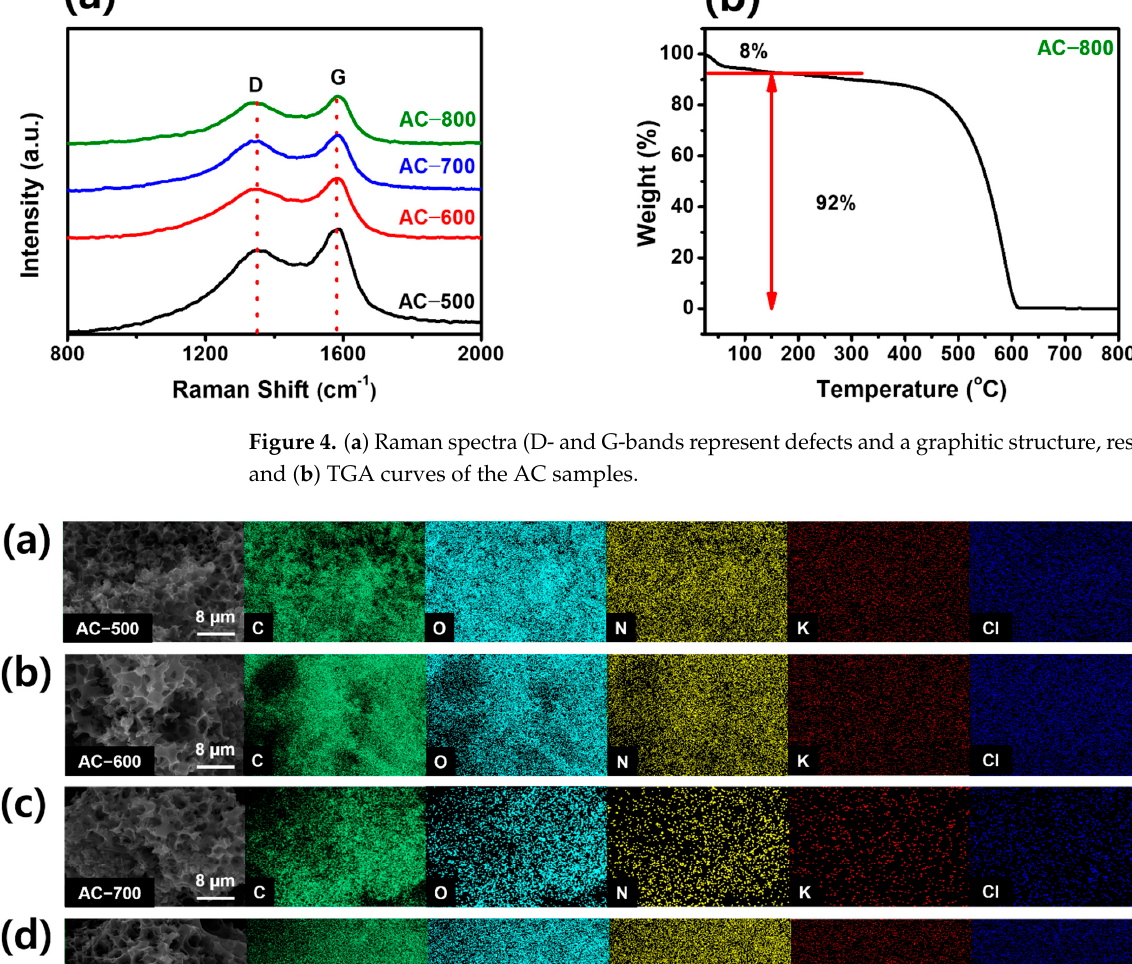
Figure 6. UV-vis absorbance spectra of the AC samples as the functional separators. Figure 7 shows CVs of the assembled coin cells with the AC functional separators (0.70 mg cm − 2 of the AC sample) and MWCNT/S cathode (2.0–2.1 mg cm − 2 ) measured in the potential range of 1.8–2.6 V vs Li/Li + at a scan rate of 0.01 mV s − 1 . All the AC samples exhibited characteristic peaks corresponding to reduction reactions and oxidation reac- tions of solid S 8 to polysulfide Li 2 S x (1 ≤ n ≤ 8). During discharging, the 1st reduction peaks were observed at 2.28–2.30 V, transforming solid S 8 to soluble polysulfide (4 ≤ x ≤ 8), and the 2nd reduction peaks were observed at 2.05–2.07 V, transforming soluble polysulfide (4 ≤ x ≤ 8) to insoluble Li 2 S x (1 ≤ x ≤ 2). During charging, two distinct oxidation peaks were observed at 2.29–2.32 and 2.37–2.40 V, respectively, transforming insoluble Li 2 S 2 /Li 2 S to ring-type S 8 [45]. However, with the rise in heating temperature, the peak areas associated with electrochemical reactions of LiPS gradually increased. As previously mentioned, as the heating temperature increased from 500 to 800 °C, the specific surface areas, micro- surface areas, and micro-pore volumes gradually increased. The AC-800 with the highest